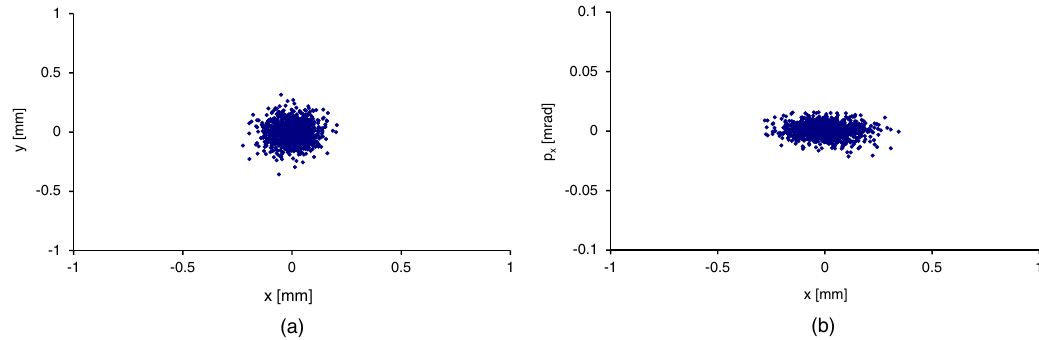
¼ 1 : 8 (cid:6) 10 (cid:3) 5 eq